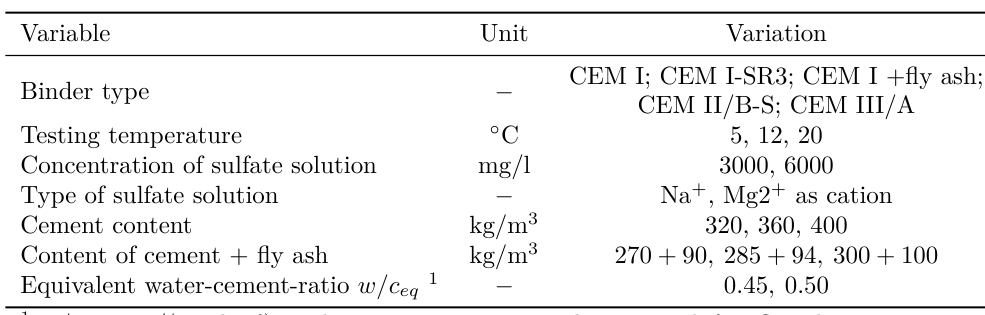
Table 1. Influencing variables on the sulfate resistance and variation